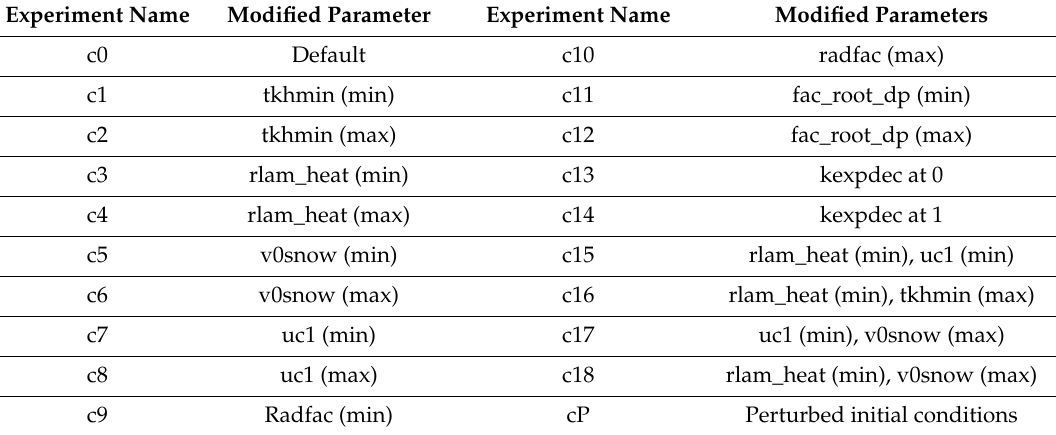
Table 2. List of sensitivity runs and associated changes in the parameters with respect to